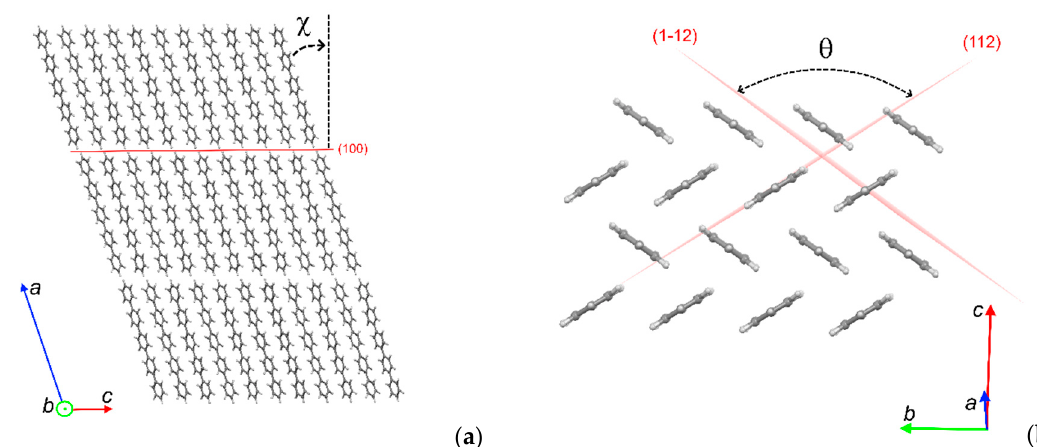
Figure 4. Crystal structure of p-quinquephenyl at 293 K: projections onto the planes (010) ( a ) and (100) ( b ).